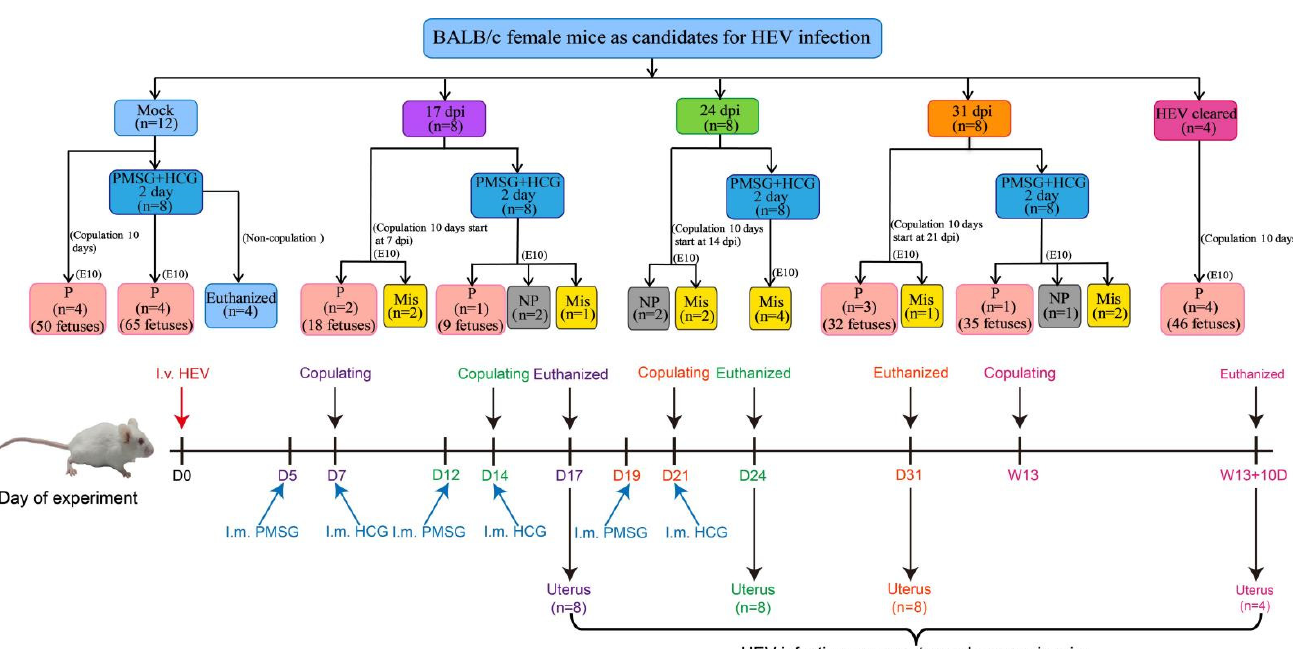
Figure 1. Diagram of HEV infection in female mice. P, pregnant; NP, nonpregnant; Mis, miscarried.